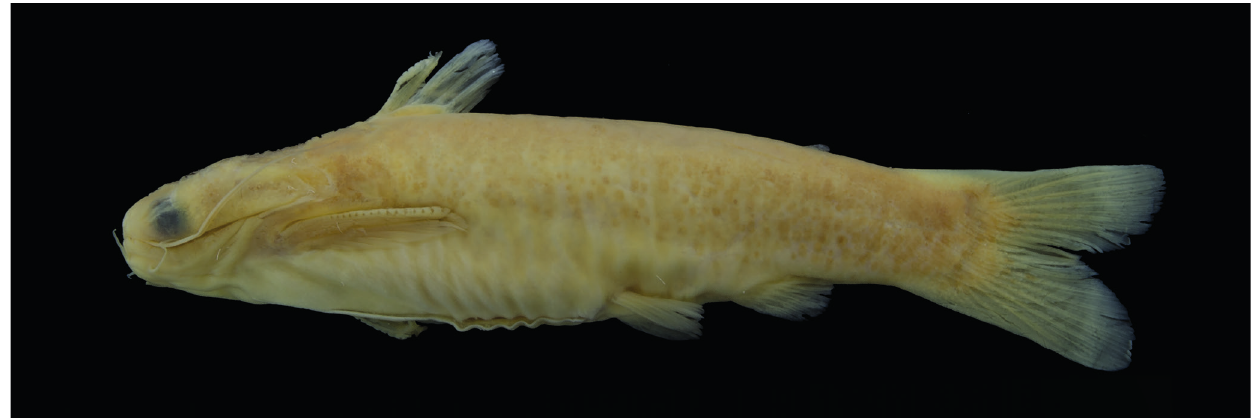
FIGURE 7 | Lateral view of Tatia simplex , MZUSP 44071, 48.3 mm SL, rio Tocantins on Jatobal